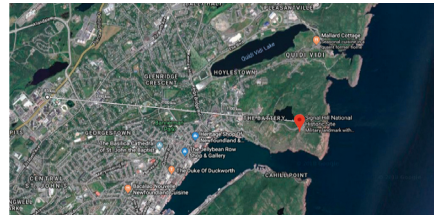
Figure 10: ESP32-LoRa range